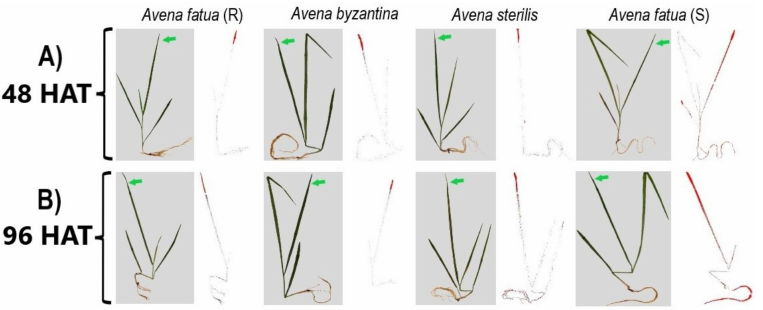
Figure 6. Digital visualization of 14 C-glyphosate movement in plants of Avena species. ( A ) 48 and ( B ) 96 h after treatment. Green arrow indicates the treated leaf.